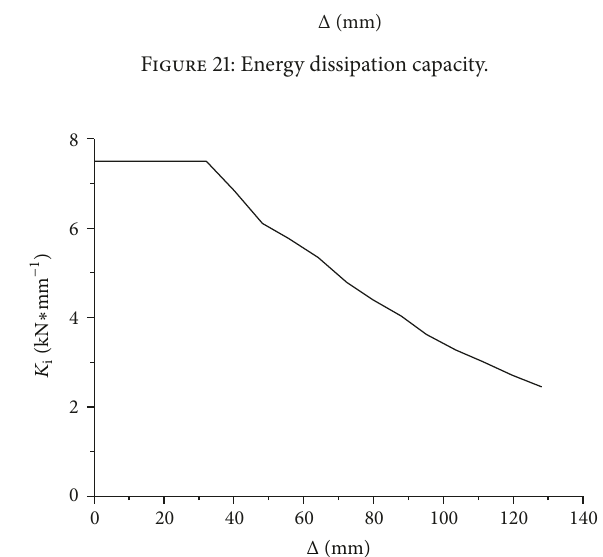
Figure 20: Hysteretic loop and energy dissipation capacity.